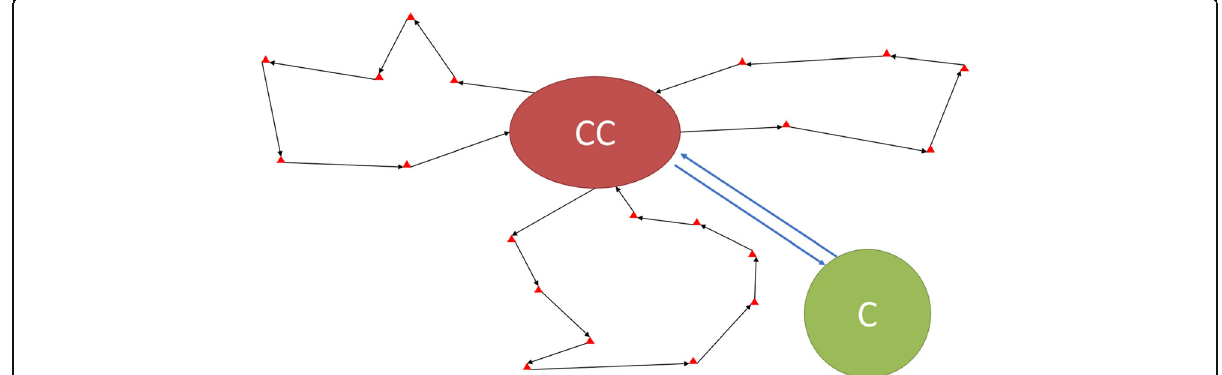
Fig. 4 Food transport system from Corbas food wholesaler (C) to middle school canteens trough the Central kitchen (CC) with single-stage and multiple